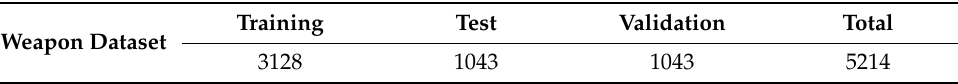
Table 2. Weapon dataset.